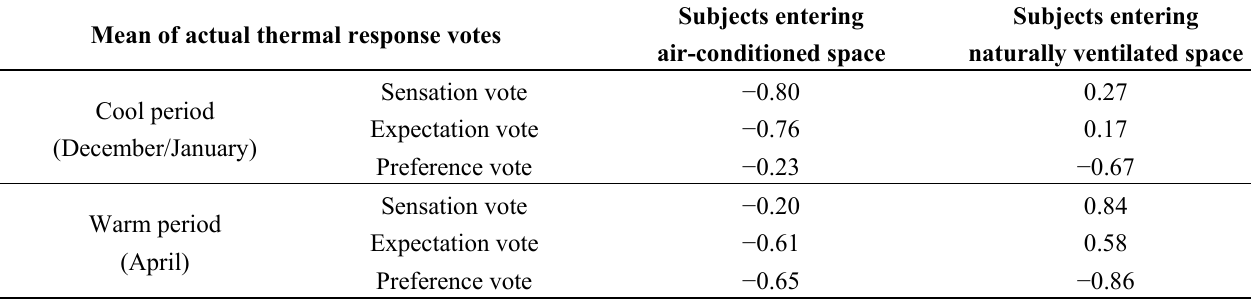
Table 2. Thermal responses for Bangkok study (adapted from